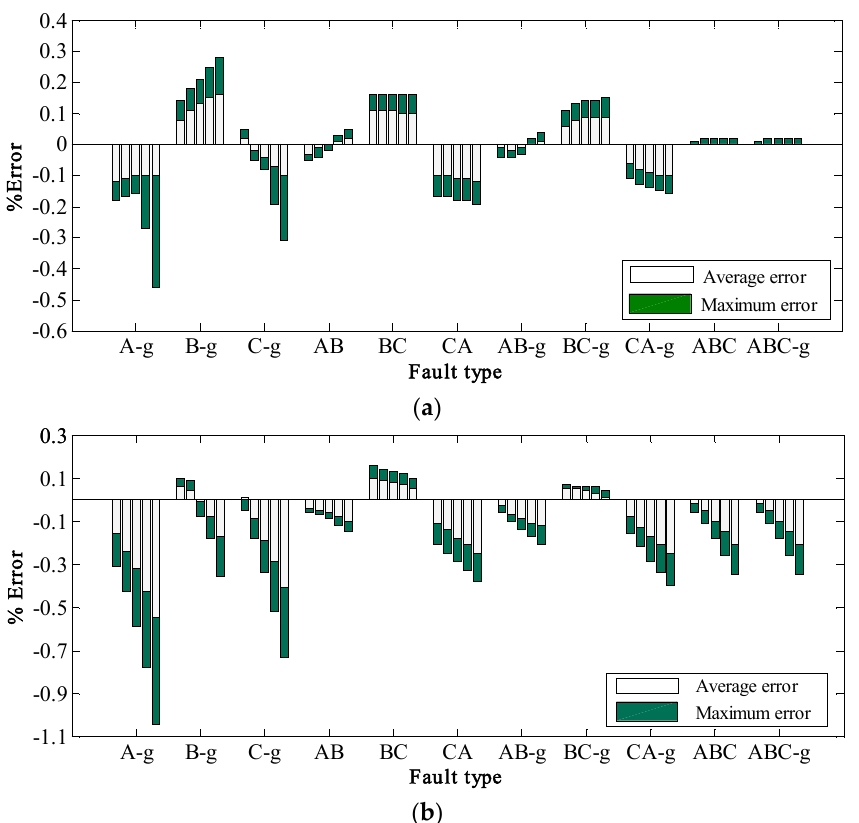
Figure 12. Percentage errors as a function of the fault resistance for the proposed method: ( a ) using the Intelligent Electronic Devices (IEDs) information, ( b ) using DER electrical model instead of IEDs information.